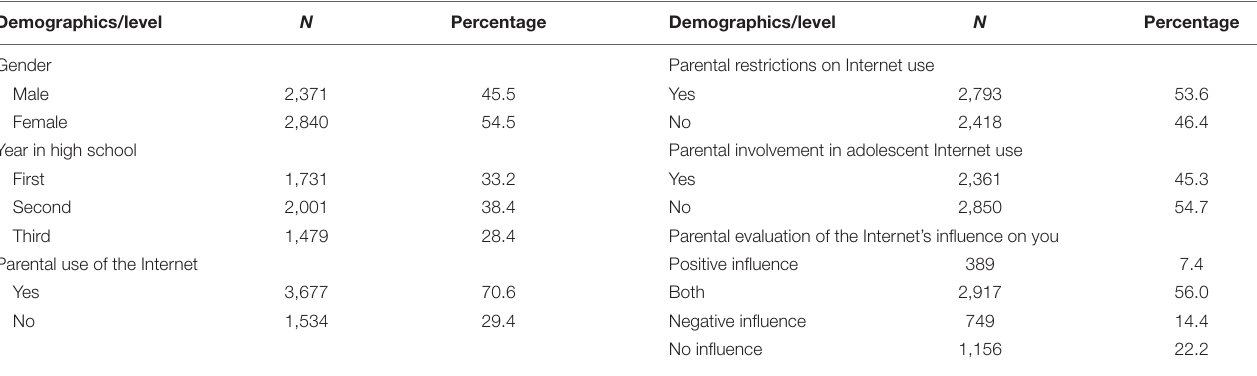
TABLE 1 | Profiles of respondents ( N =